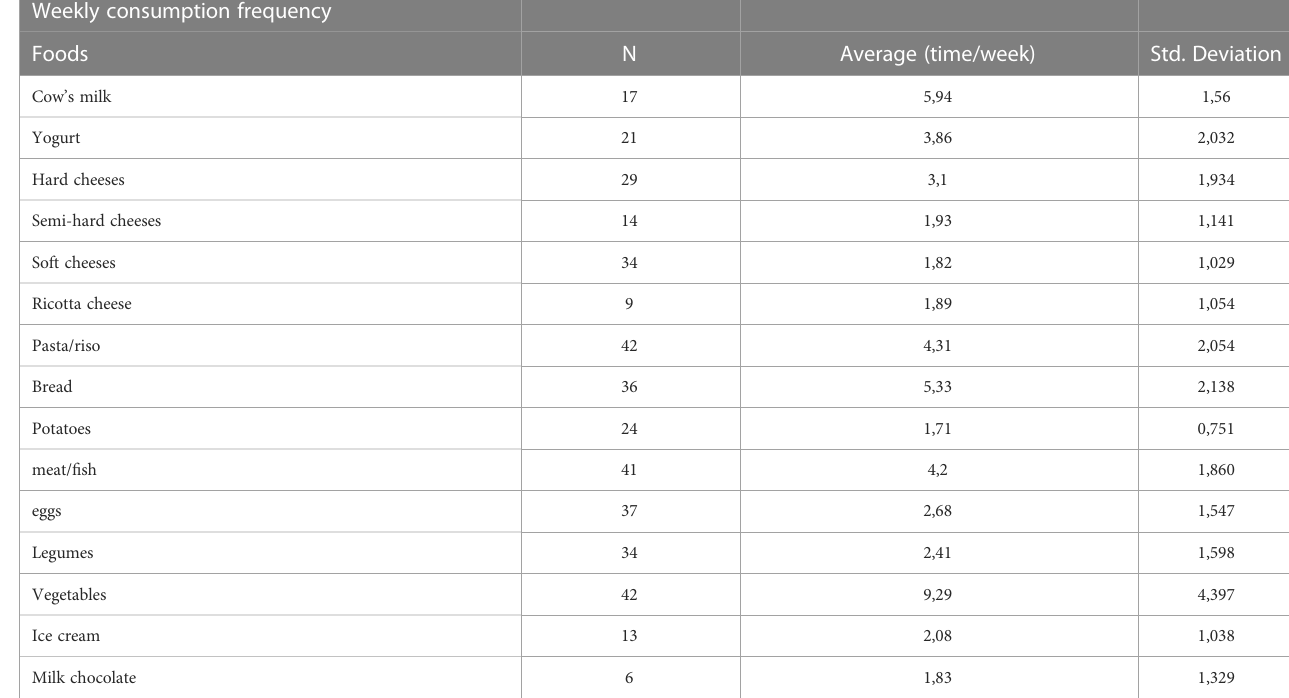
TABLE 6 Frequency of consumption of the different food